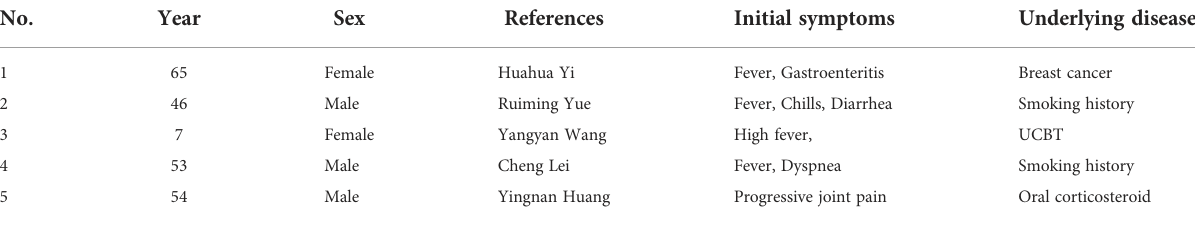
TABLE 3 Clinical data of 5 patients diagnosed with legionella infections based on mNGS; UCBT, umbilical cord blood stem cell transplantation.